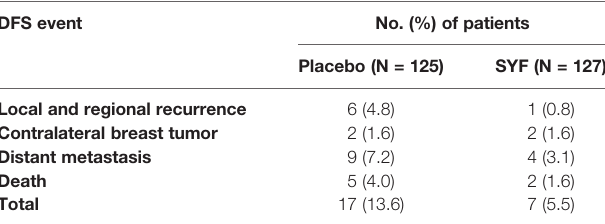
TABLE 3 | First DFS event by treatment.